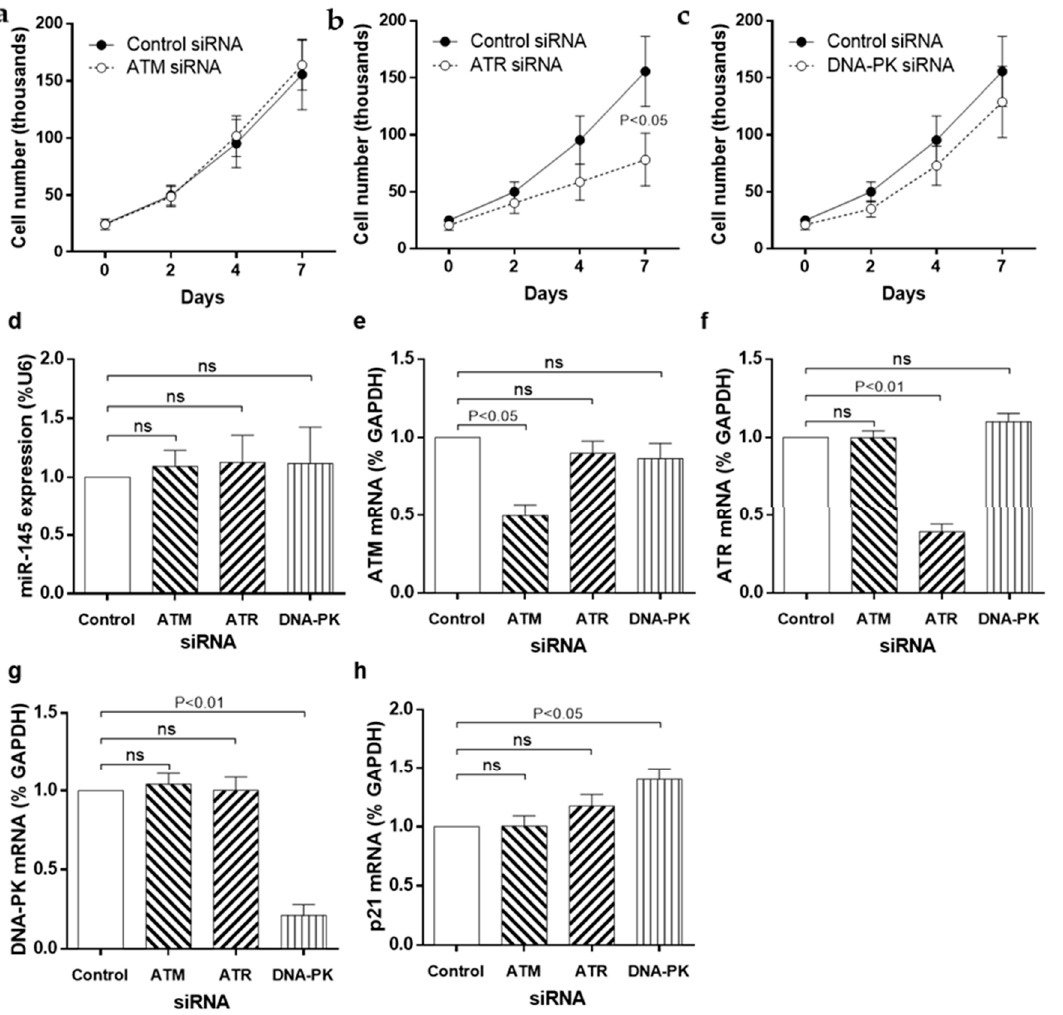
Figure 4. siRNA knockdown of apical kinases of the DNA damage response pathway modulates proliferation and gene expression. ( a ) SMC were transfected with siRNA targeted to ATM, ( b ) ATR or ( c ) DNA-PK for 6 h and then placed into FGM for up to 7 days. Cell counts were performed on days 0, 2, 4 and 7 ( n = 4). RNA was extracted at 72 h and the expression of ( d ) miRNA-145 , ( e ) ATM , ( f ) ATR , ( g ) DNA-PK and ( h ) p21 measured using RT-PCR ( n = 5).